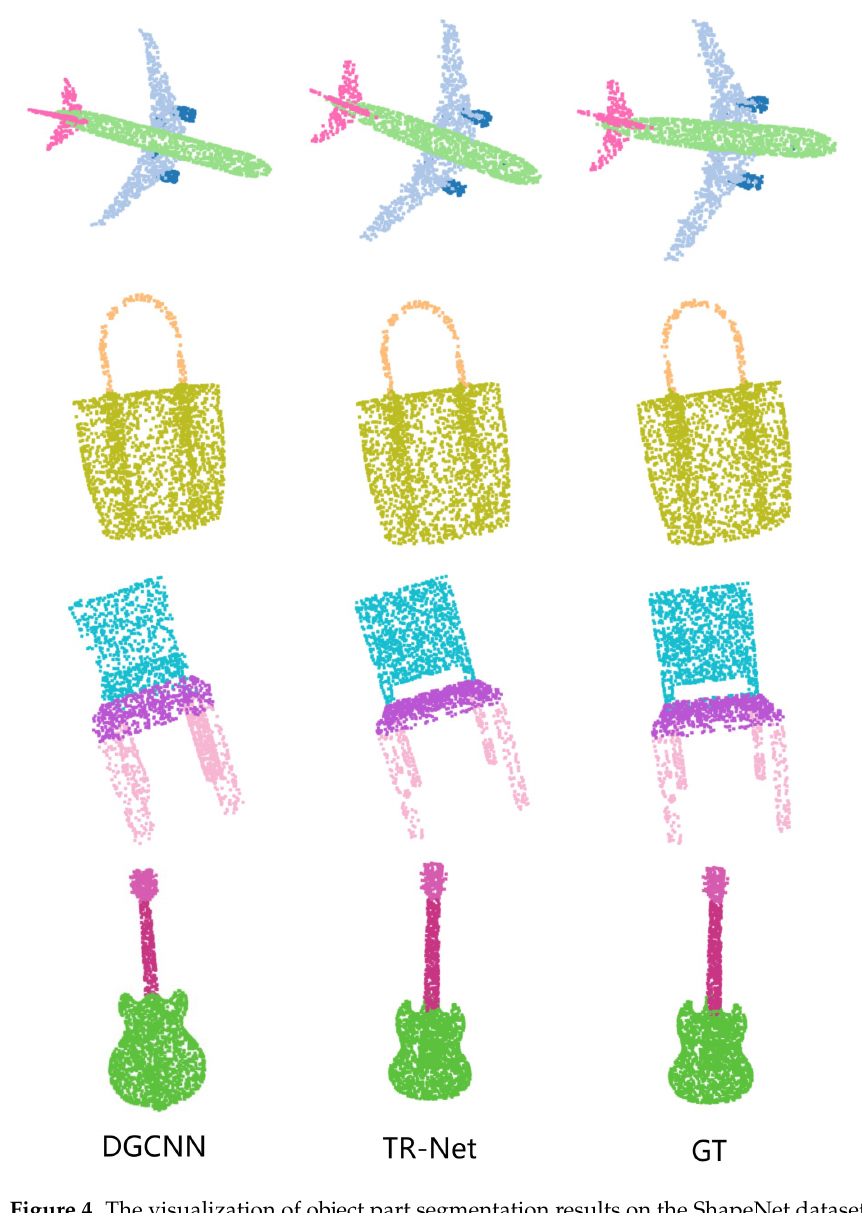
Figure 4. The visualization of object part segmentation results on the ShapeNet dataset. GT denotes Ground